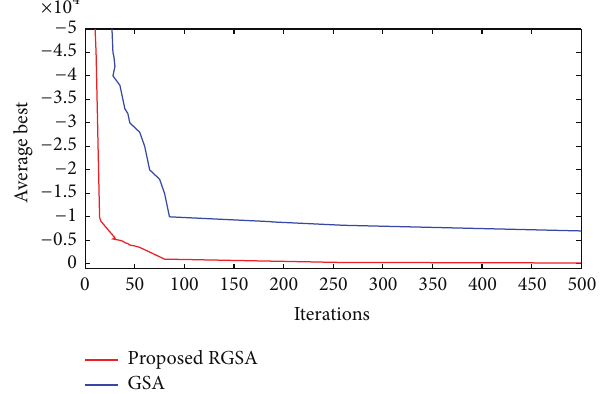
Figure 14: Feature selection improvement of proposed RGSA and